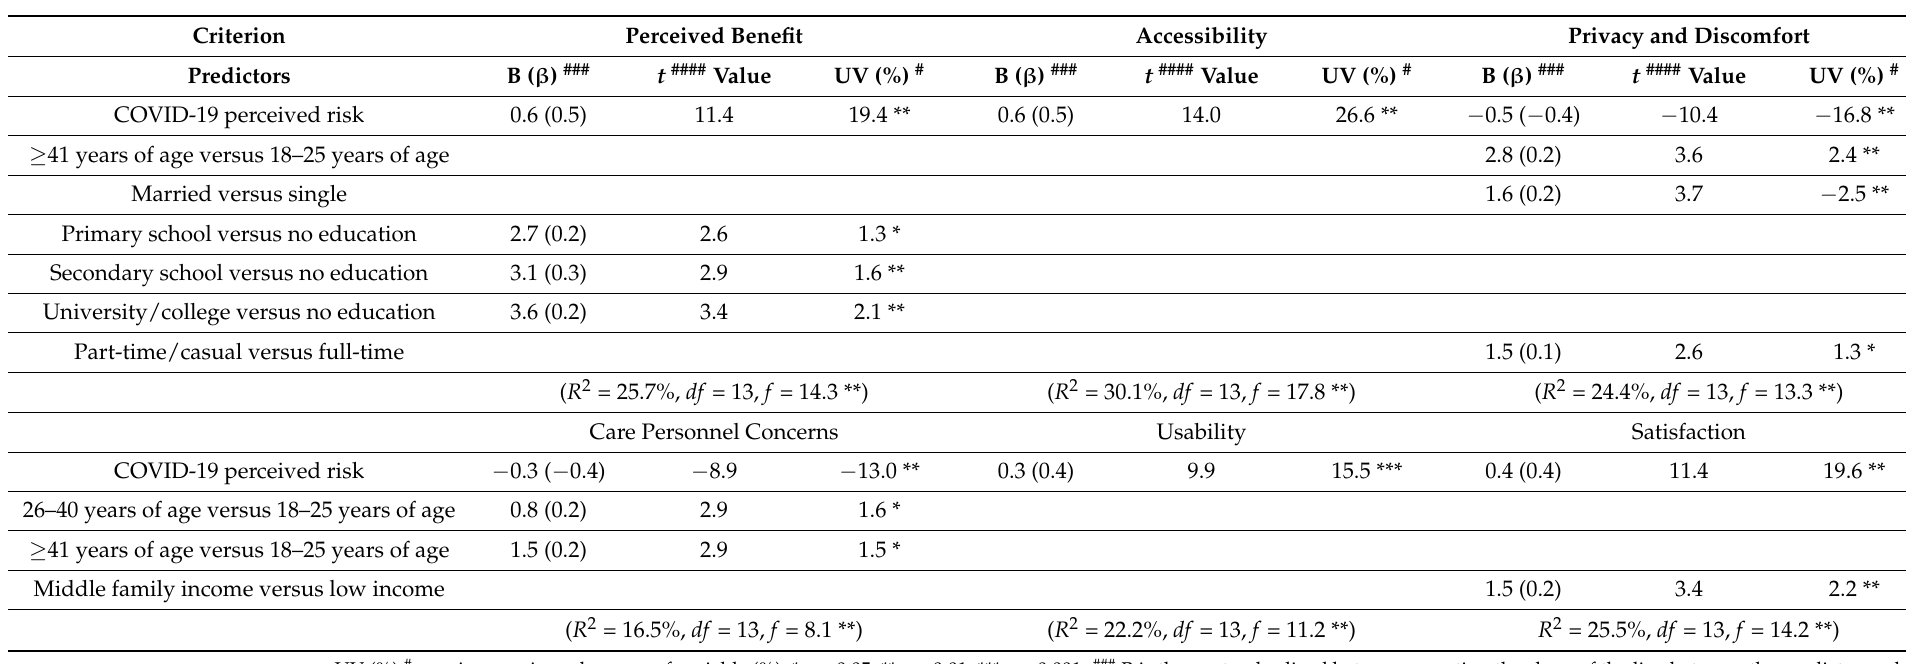
Table 6. Summary of multiple regression analyses for COVID-19 perceived risk predicting different domains of telemedicine use while controlling demographic variables ( n =